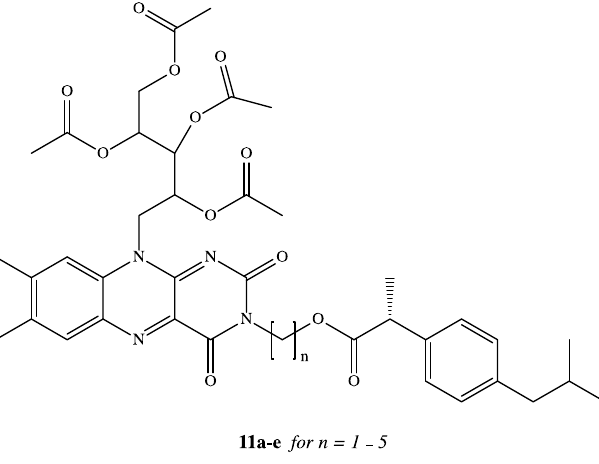
Figure 7. Dexibuprofen tetraacetylriboflavin conjugates.